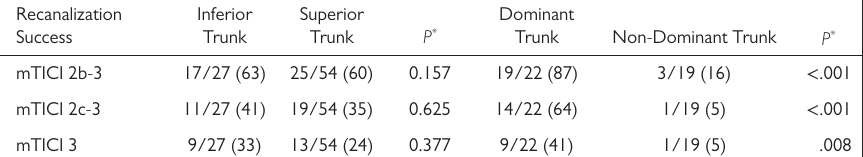
Table 3. Recanalization Results Dependent on Stent Retriever Placement in M1 Occlusion at First Pass of